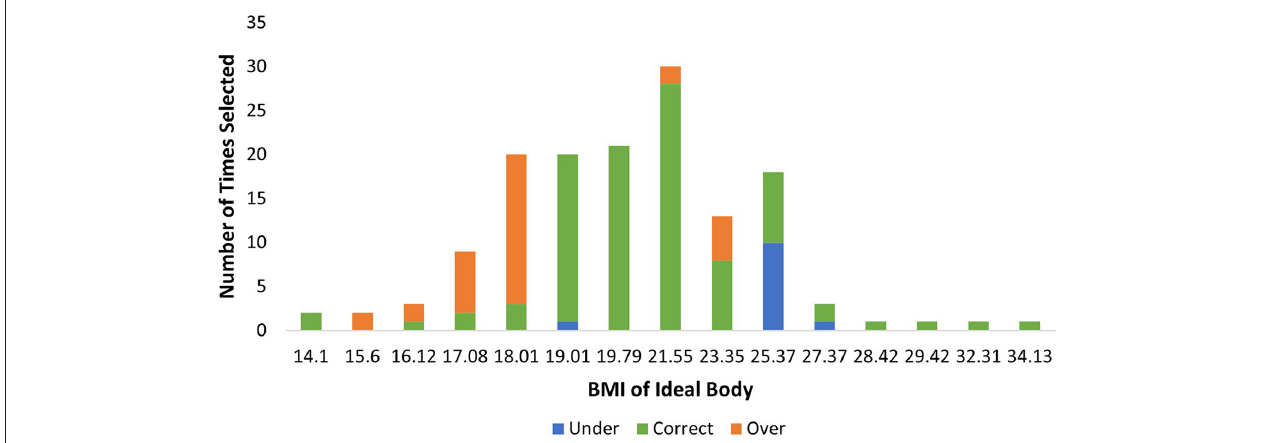
FIGURE 1 | Distribution of ideal body selection frequencies by BMI, with classification accuracy indicated.